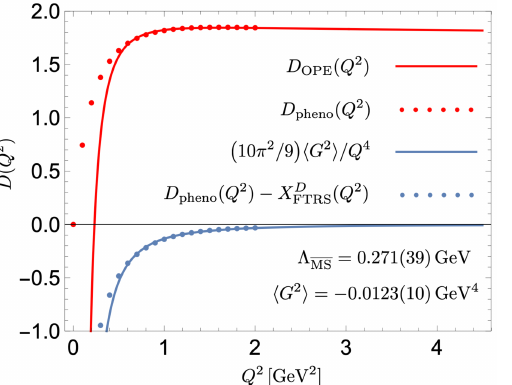
JHEP02(2022)016 Figure 4 . Comparison of D OPE ( Q 2 ) (red solid) Figure 5 . D pheno ( Q 2 ) − X D ( Q 2 ) vs. 1 /Q 4 FTRS and D pheno ( Q 2 ) (red dots). The former is de- with Λ = 0 . 271 GeV . The solid, dashed, and MS √ √ √ termined by fitting to the latter in the range dotted lines correspond to µ = τ, 2 τ, τ/ 2 , 0 . 6 ≤ Q 2 ≤ 2 . 0 GeV 2 . Also (10 π 2 / 9) h G 2 i /Q 4 respectively. Vertical short lines show the bound- (blue solid) and the difference D pheno ( Q 2 ) − aries of the range used for the fit. In this range, X D ( Q 2 ) (blue dots) are compared. the behavior is almost proportional to 1 /Q 4 , FTRS which is consistent with OPE. Figure 6 . Comparison of X D ( Q 2 ) , X D ( Q 2 ) and X D ( Q 2 ) for Λ = 0 . 271 GeV . The dashed FTRS FO RG MS and dotted lines correspond to the variation of the scale by a factor 2 and 1/2, respectively, from its standard value